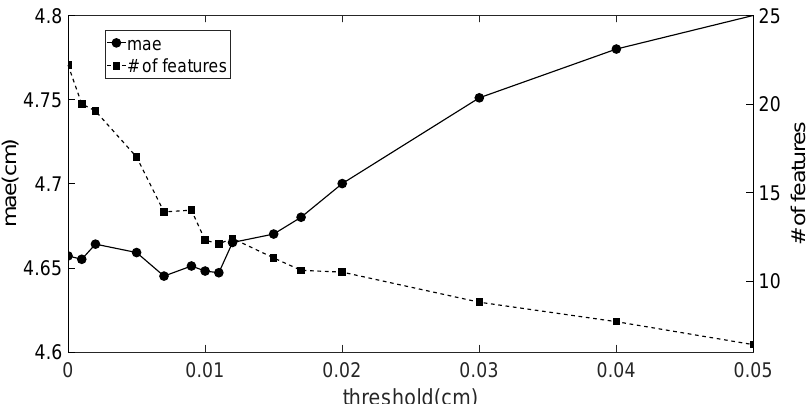
Figure 7. Mae and number of features as a function of the threshold in the addition